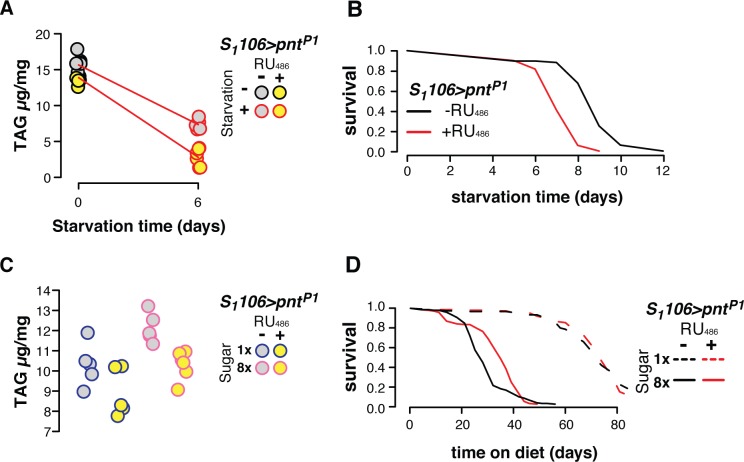
Pnt impacts the response to nutritional stress.(A) Over-expressing PntP1 in the gut and fat body accelerates loss of TAG under starvation stress (linear model: RU486:starvation F1,19 = 7.03, p = 0.02; see S4 Fig for corresponding plot of body mass). (B) Over-expressing PntP1 in the gut and fat body reduces survival under starvation stress (log-rank test p = 1.3e-14). (C) Over-expressing PntP1 in the gut and fat body reduces accumulation of TAG on a high-sugar diet. PntP1 reduced TAG (linear model F1,17 = 14.4, p = 1.4e-3), and sugar increased TAG (linear model: F1,17 = 15.25, p = 1.1e-3), with PntP1 appearing to counteract the effect of sugar (mean±SE: low sugar-RU486 10.31±0.48, high sugar+RU486 10.30±0.29; t-test t = 0.009, p = 0.99). (D) Over-expressing PntP1 in the gut and fat body enhances survival on a high-sugar diet (Cox Proportional Hazards diet:RU486 p = 6e-3).